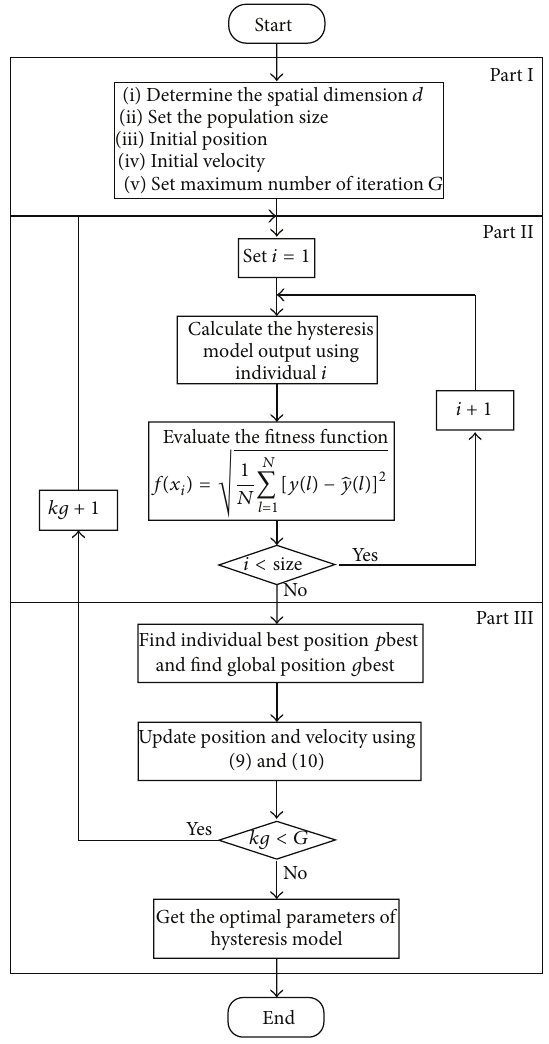
Figure 3: Flowchart of the identification hysteretic model parame- ters